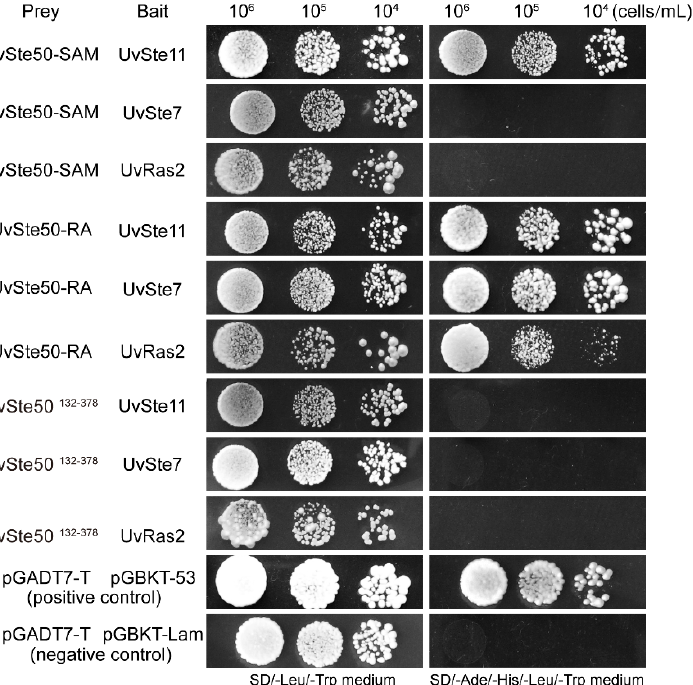
Figure 10. SAM and RA domains play different roles in the interactions of UvSte50 with UvSte11, UvSte7, and UvRas2. UvSte50 ‐ SAM (1–131 aa), UvSte50 ‐ RA (379–499 aa), and UvSte50 132–378 (the UvSte50 middle region) constructs were assayed for their interactions with the UvSte11, UvSte7, and UvRas2 bait constructs. The resulting yeast transformants were assayed for growth on SD/ ‐ Leu/ ‐ Trp and SD/ ‐ Ade/ ‐ His/ ‐ Leu/ ‐ Trp medium.